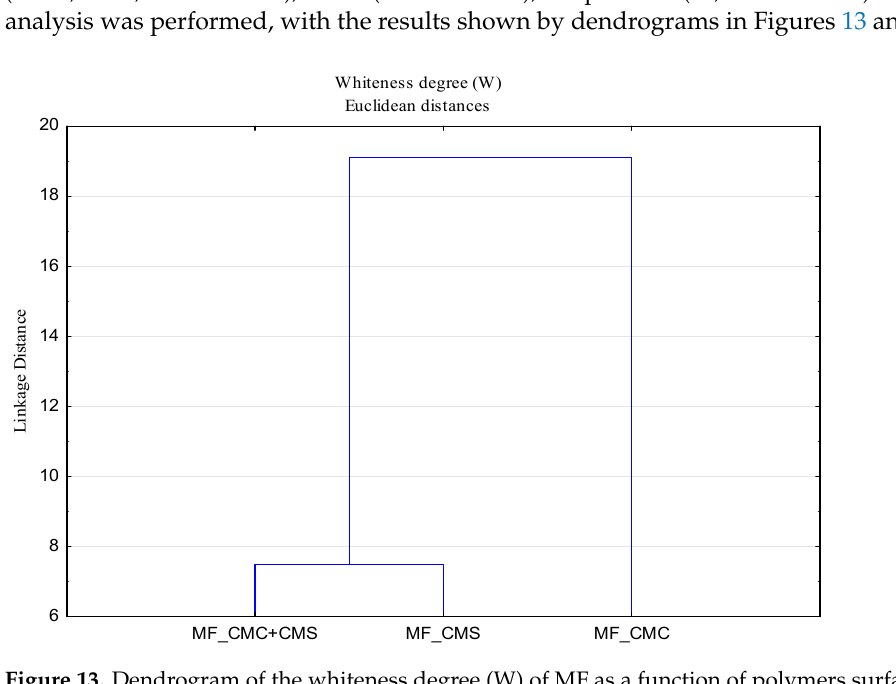
Table 5. Correlation matrix of CMC+CMS.